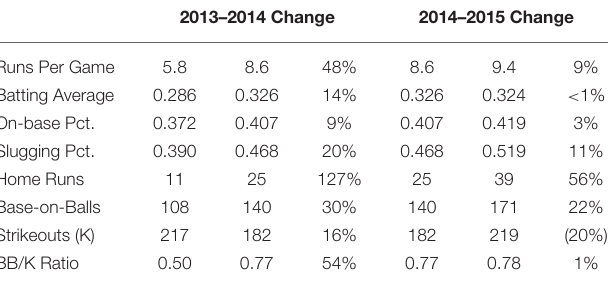
TABLE 3 | Change in Batting Statistics for Cooperating